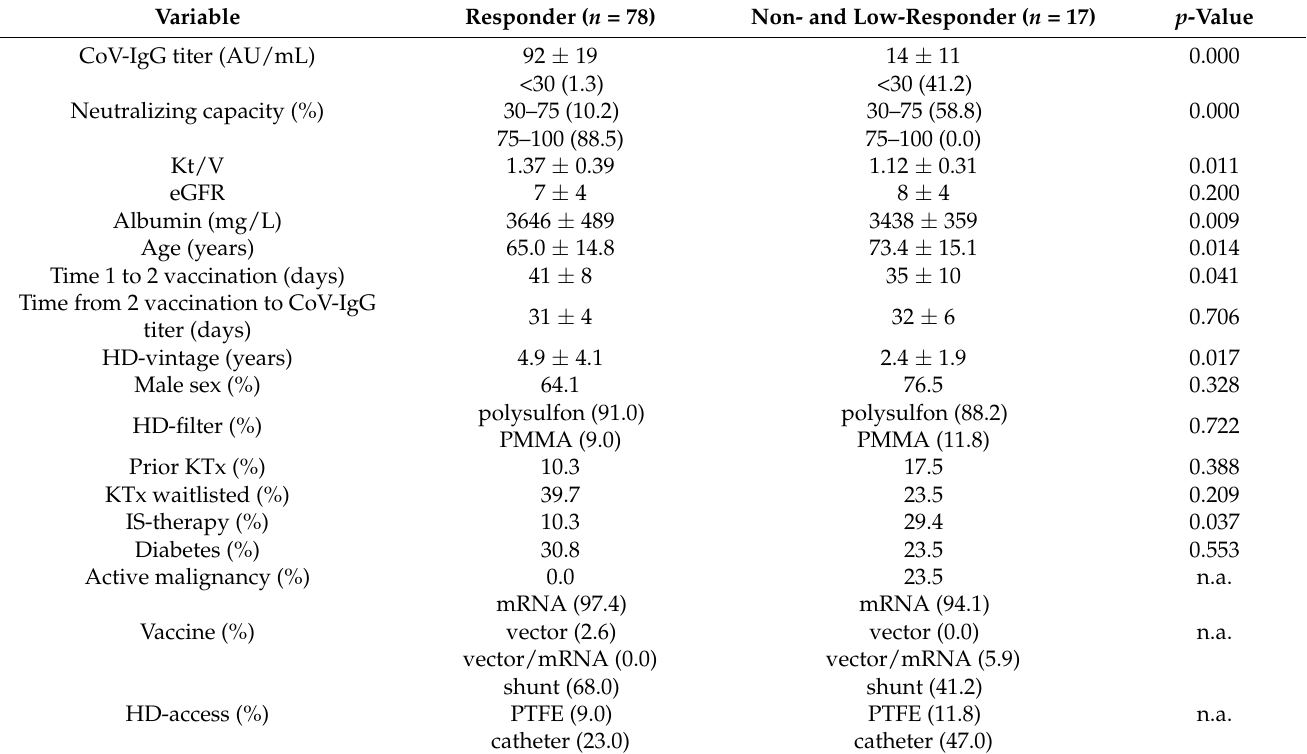
On univariable logistic regression analysis albumin (RC-B = − 0.046, p = 0.042, Exponent-B = 0.955, 95% CI 0.913–0.998) age (RC-B = 0.002, p = 0.003, Exponent-B = 1.002, 95% were shown to be potential risk factors for vaccination non-response. On multivariable binary logistic regression analysis age and immunosuppressive therapy remained strong predictors for vaccination